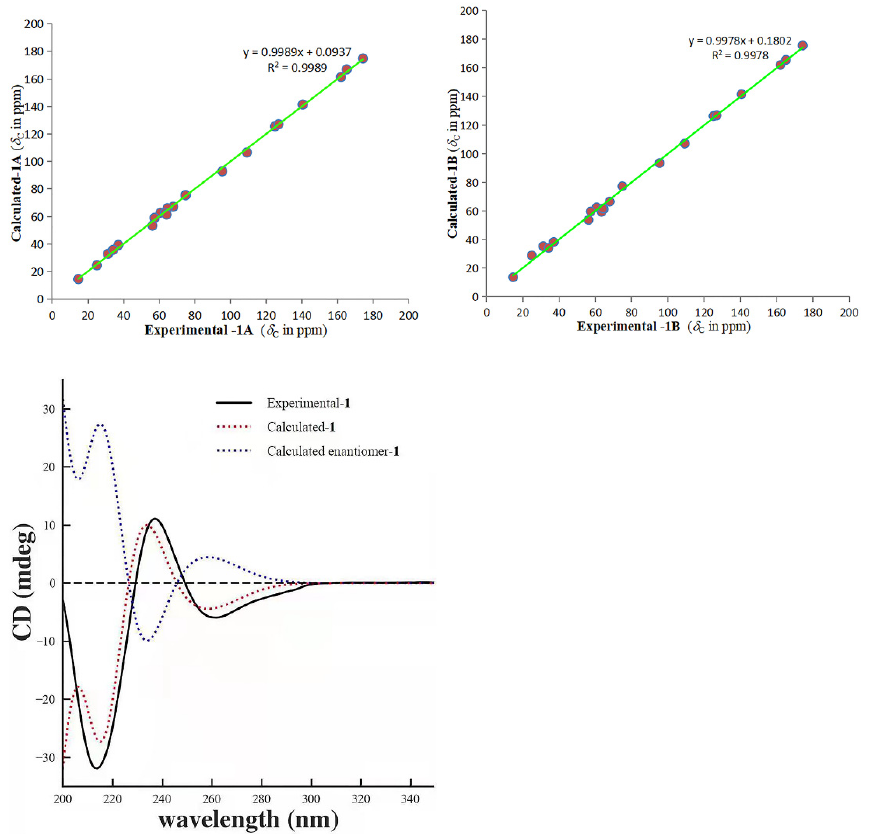
Figure 4. Regression analysis of the NMR calculations of the two possible configurations ( 1A and 1B ) and ECD calculation curves of 1 .